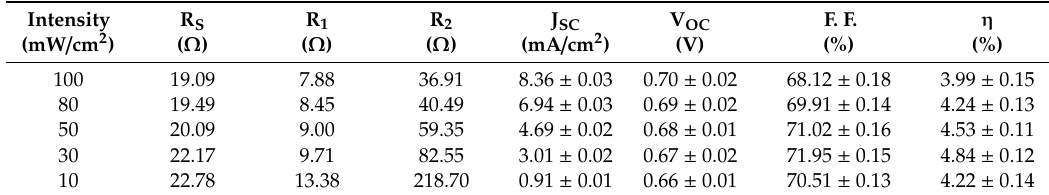
Table 2. Parameters of DSSC based on TiO 2.